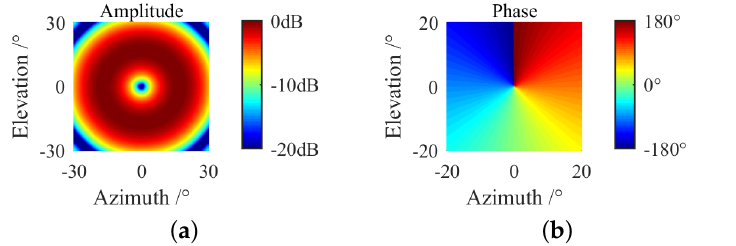
Figure 6. The amplitude ( a ) and phase ( b ) distributions of the vortex beam ( l = 1). I n exp [ i 2 k sin θ ( x n cos ϕ + y n sin ϕ )] can be expressed as The term ∑ N n = 1 (cid:2) (cid:0) (cid:1)(cid:3) i L α α + L β β I 2 x n / ∑ N I 2 y n / ∑ N I 2 I 2 exp . L α = 2 k ∑ N and L β = 2 k ∑ N are n n n n n = 1 n = 1 n = 1 n = 1 the phase gradients along the azimuth and elevation directions in the echo, respectively. Compared with the linear array, the echo of the circular array increases the term exp ( iL β β ) brought by the elevation position of the scattering point. Assuming that there are M scat- tering points at the same range r , the azimuth angle, elevation angle and RCS of the m -th scattering point are α m , β m and σ m , respectively. The sum echo of the M scattering points is